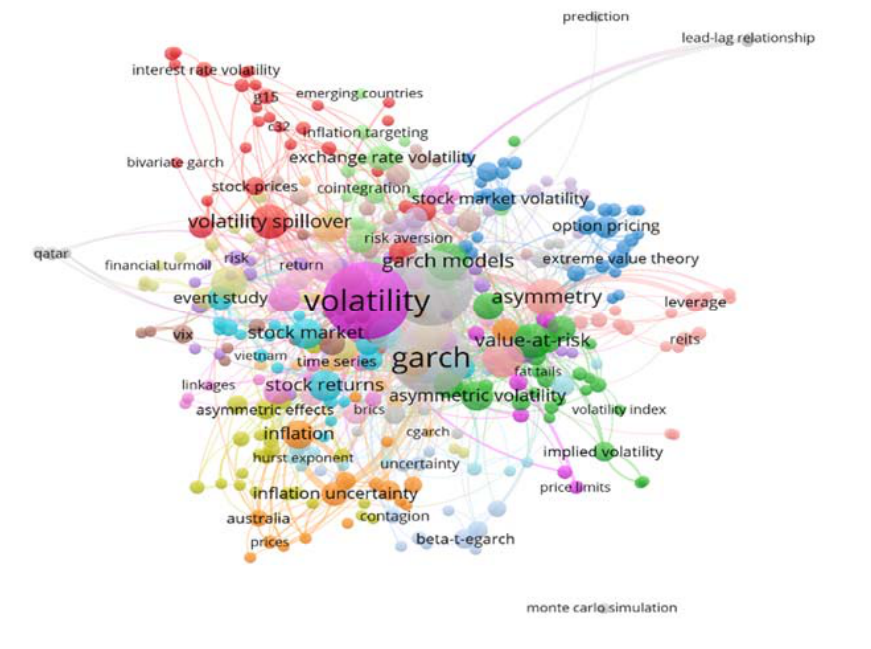
Figure 7. Co ‐ occurrence of author keywords. Source: Elaborated by authors using data extracted from Scopus.